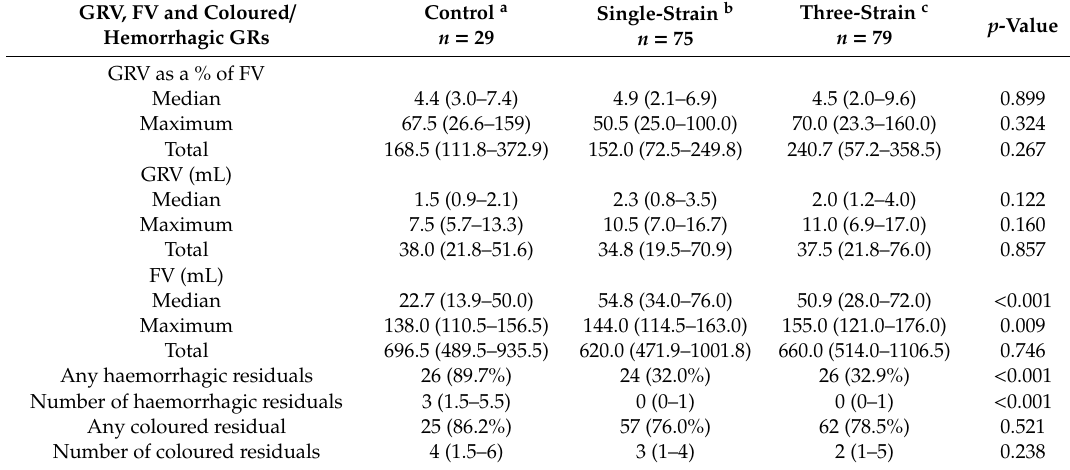
Table 4. Summary of daily Gastric Residual Volumes (GRV), feed volumes (FV), and colour of aspirate from commencement of minimal enteral feeds until reaching 150 mL / kg /